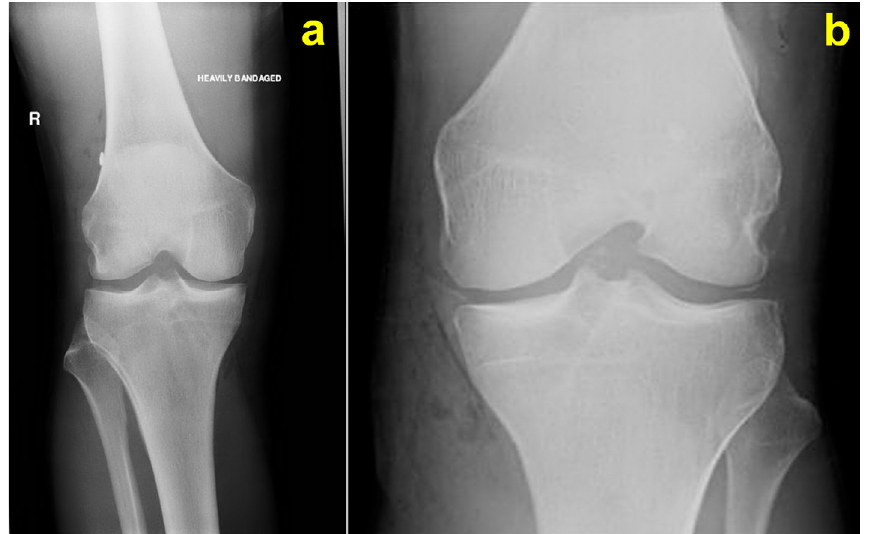
Figure 1. (a) Post-operative anteroposterior view of a right knee after ACLR showing no debris, (b) post-operative anteroposterior view of a left knee after ACLR showing